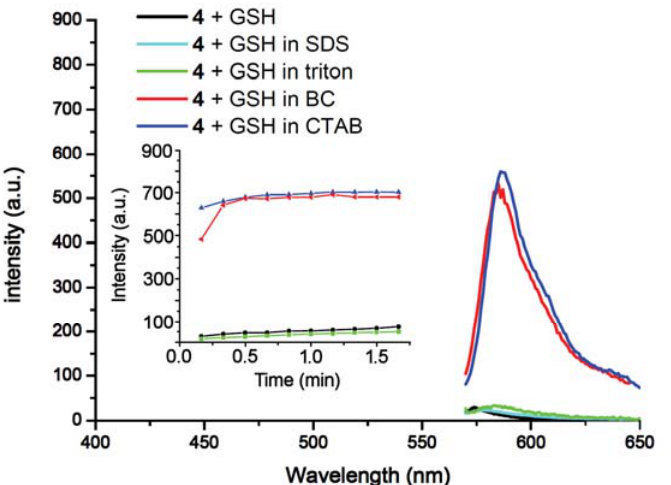
Figure 4. Surfactant-mediated responses of 4 towards GSH. Fluorescence spectra ( λ = 565 nm) of 4 (2.5 μ M) upon addition of GSH (2 equiv) in pH 7.4 buffered ex (phosphate buffer, 50 mM) surfactant media [(SDS, 10.0 mM), (Triton X-100, 0.3